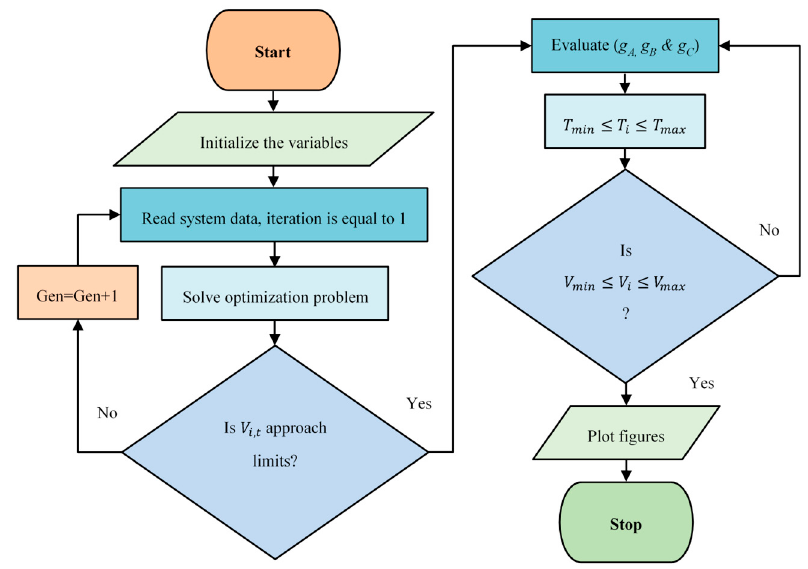
Figure 3. Flowchart of the multiobjective optimization of ATCTrs.